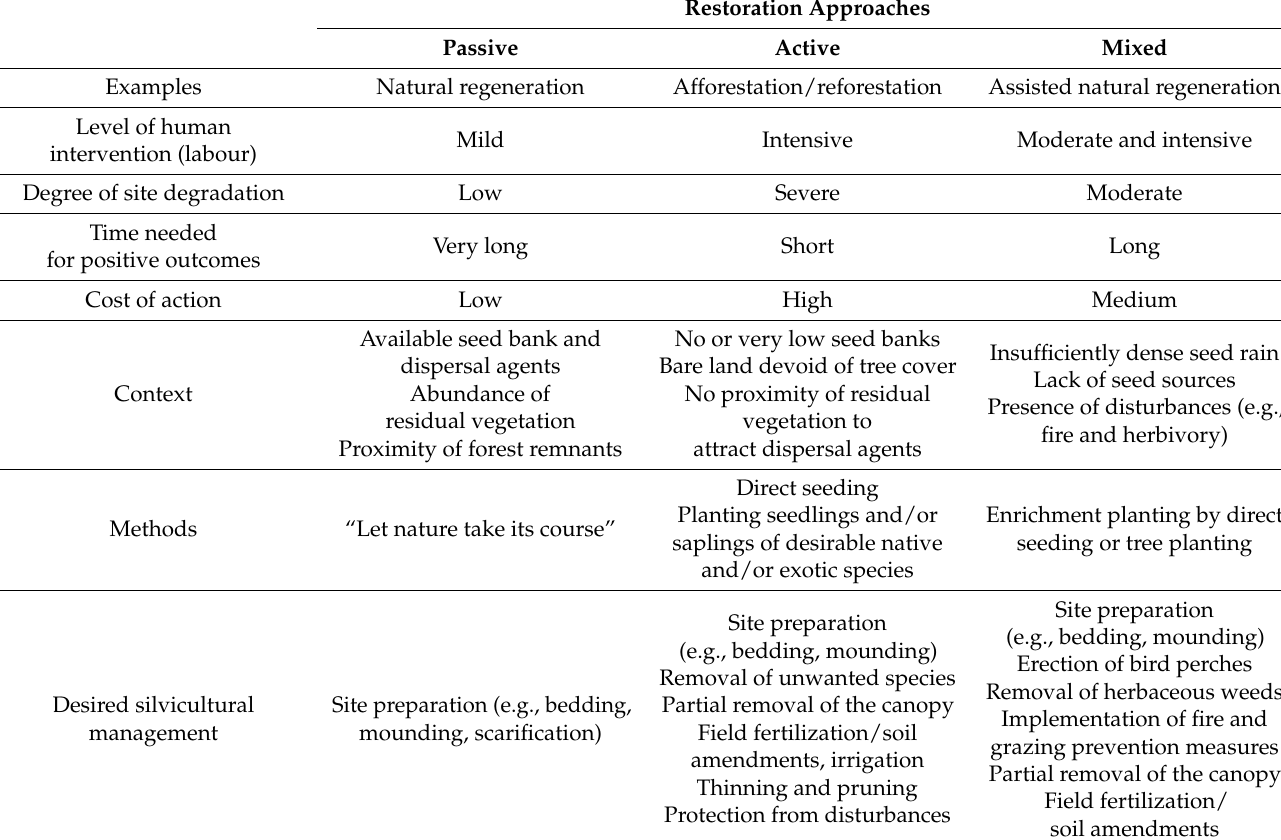
Table 1. Practical considerations for the selection of an FLR